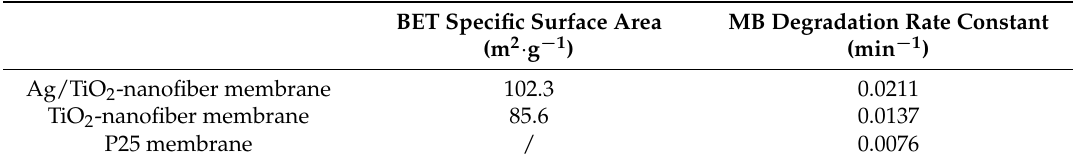
Table 2. MB degradation rate constant under solar irradiation by using different TiO 2 -based photocatalytic membranes (Data from Liu et al.